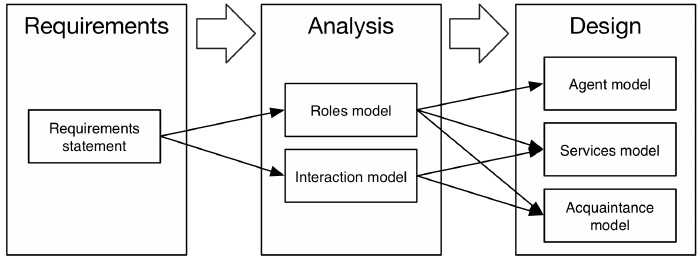
Figure 1. Process and models of Gaia, a methodology for agent-oriented analysis and design, applied to the interactive museum exhibition module case study.